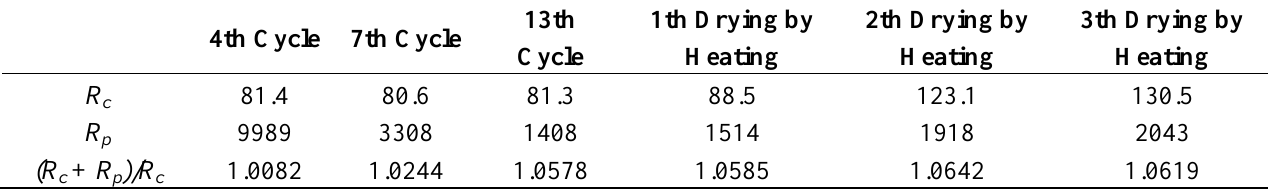
Table 6. Curve fitting results for Nyquist plots of monitoring point W1.